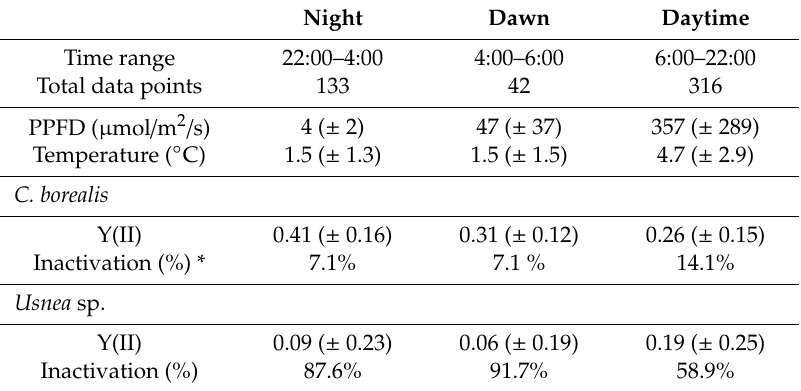
Table 1. Mean photosynthetic e ffi ciency Y(II), PPFD, and temperature changes during dawn, daytime, and night. Numbers in parentheses indicate ± standard